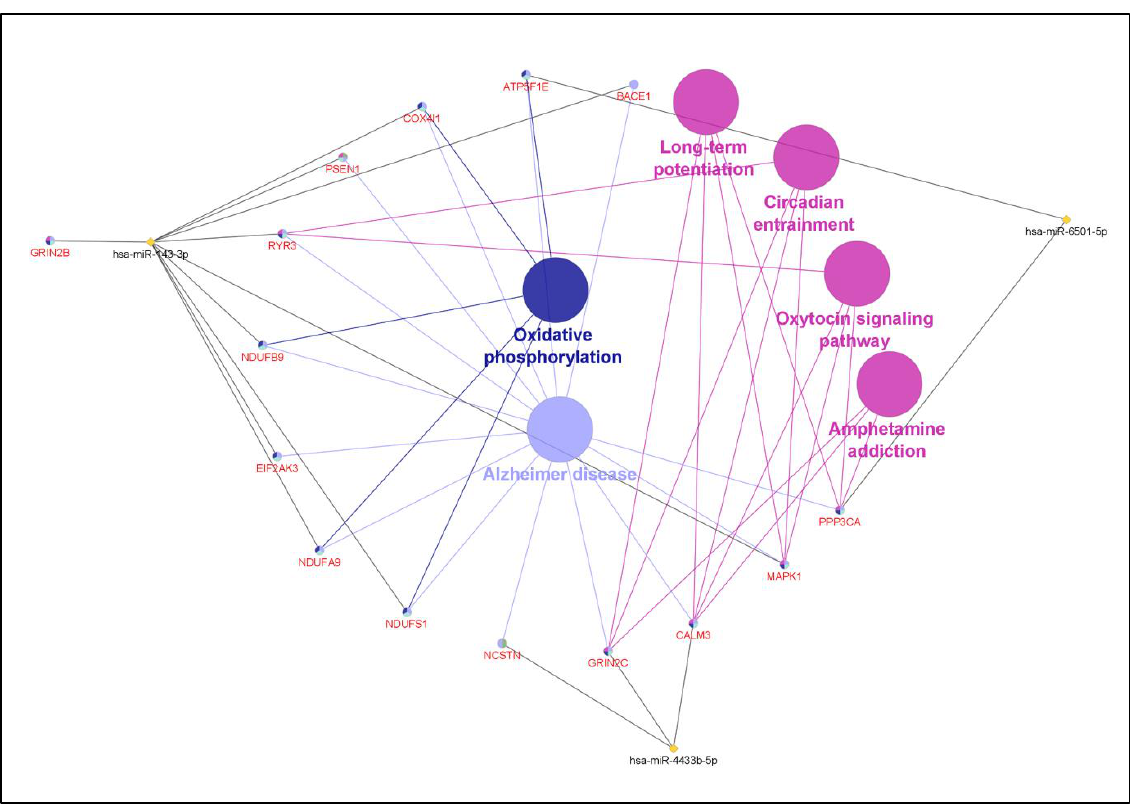
Figure 5. DEMi signatures and target genes enriched in KEGG pathways. Enriched pathways are indicated by the nodes, and the interactions between the pathways and genes are represented by lines. The different colours of the nodes depict the different functional groups of the pathways.